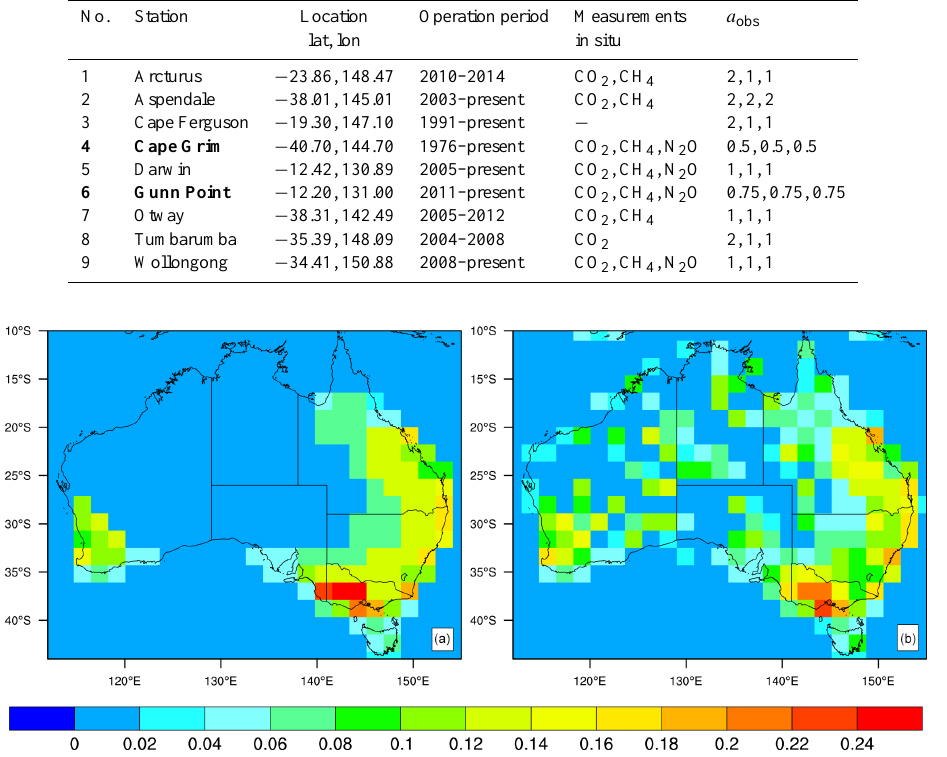
Figure 3. Prior N 2 O flux uncertainties (1 standard deviation) in milligrams nitrogen per square metre per week at 1.8 ◦ resolution for (a) the total (agriculture). The random variation in flux uncertainties used for the sensitivity test is shown in (b)